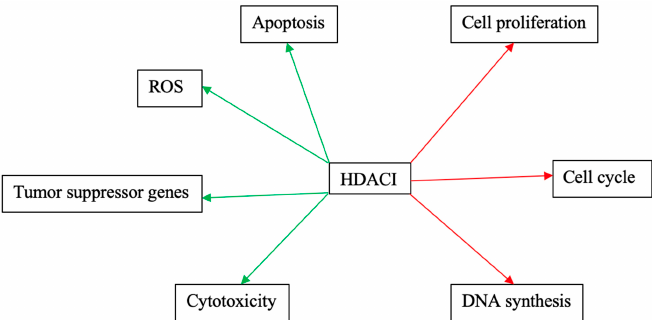
Figure 4. Mechanisms of action of phytopharmaceuticals as monotherapies on cervical cancer. Red arrows: Inhibitory effects. Green Arrows: Activating effects. Table 4 summarizes the possible combinations of HDACIs with other, standard or alternative, treatment agents in the context of cervical cancer therapy.